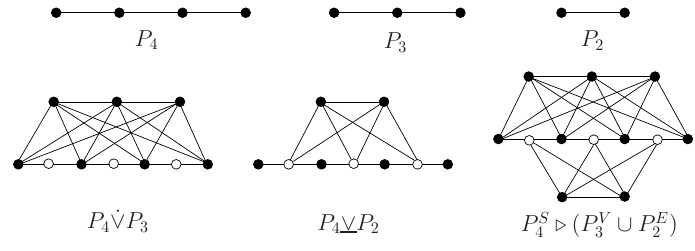
Figure 1. Some related